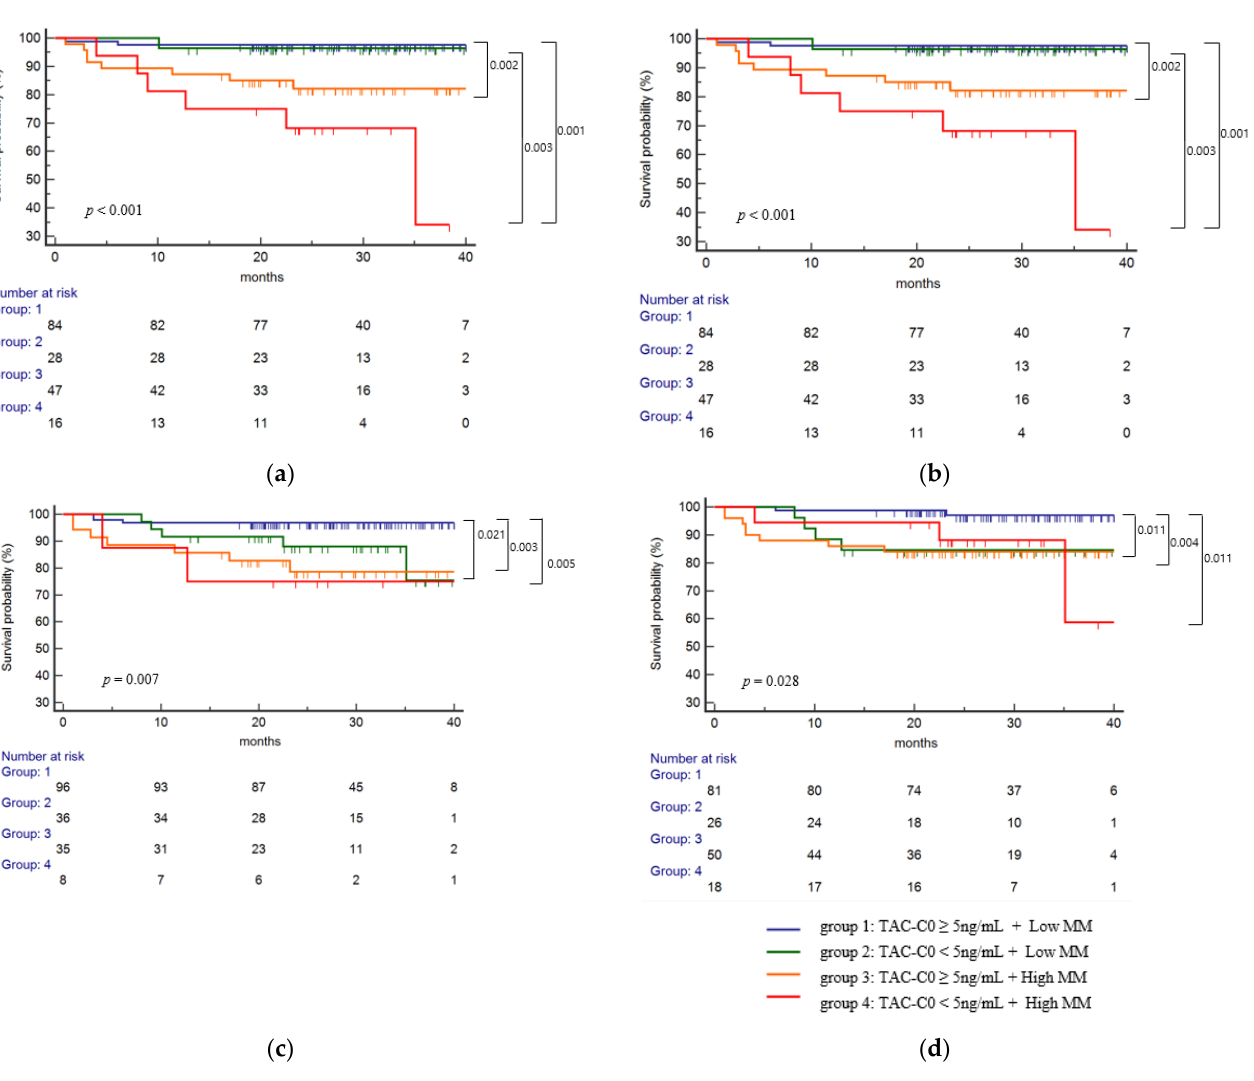
Figure 4. Combined effects of eplet mismatch and TAC-T0 on the risk of class II dnDSA development. Patients were divided into four groups based on time-weighted TAC-C0 up to post-transplant 1st year of 5 ng/mL. ( a ) Combined effects of single molecular eplet mismatch and TAC-T0 for the risk